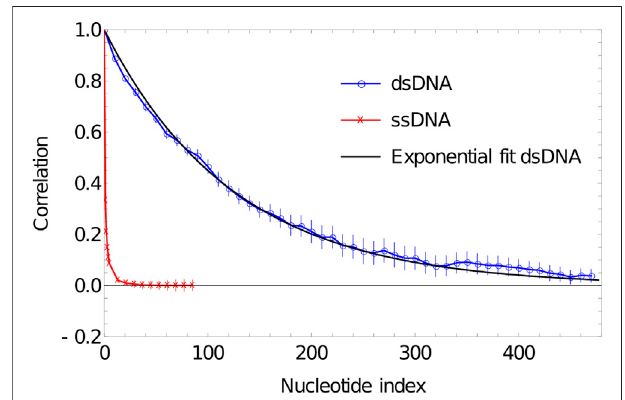
FIGURE 4 | Plot of correlation of inter-segment vectors vs distance (number of base pairs along the DNA) for 500 dsDNA (blue curve) and 100 ssDNA (red curve). dsDNA fi tted with an exponential decay with a decay constant of